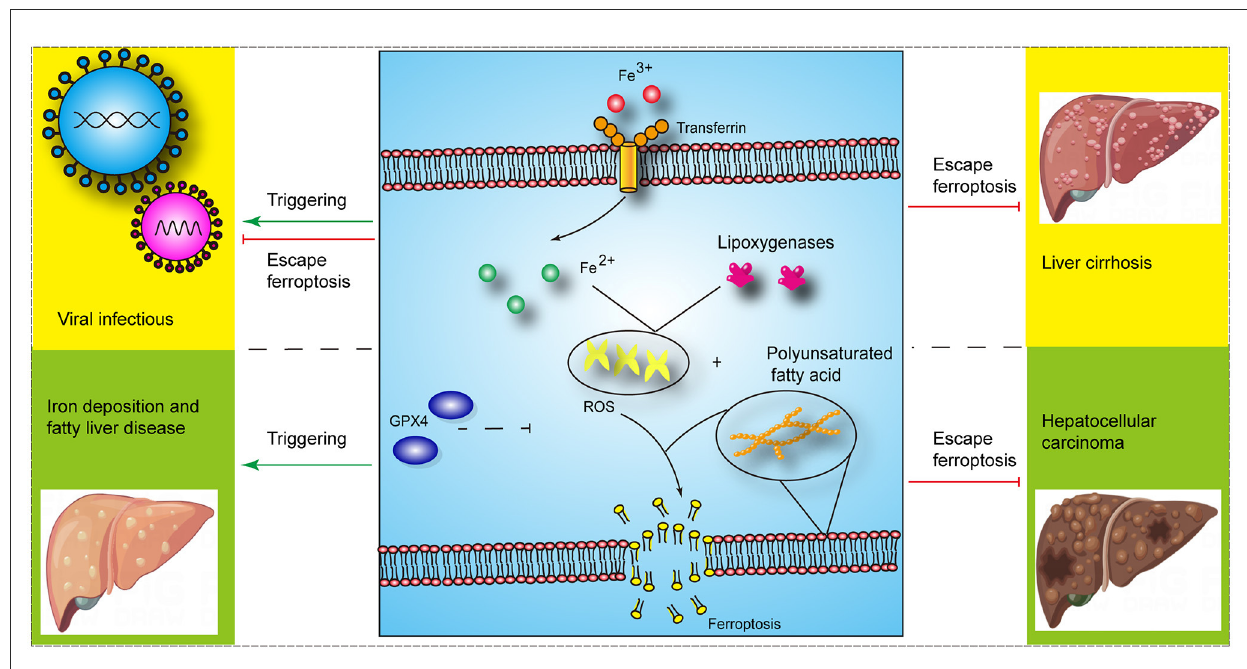
FIGURE1 The role of ferroptosis in liver diseases (Some image elements came from Figdraw with